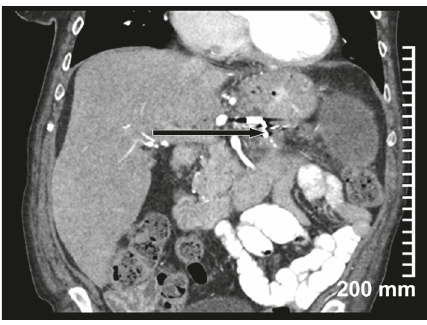
Figure 7: Coronal CT abdomen image showing vascular coils in close proximity of distal duodenum.